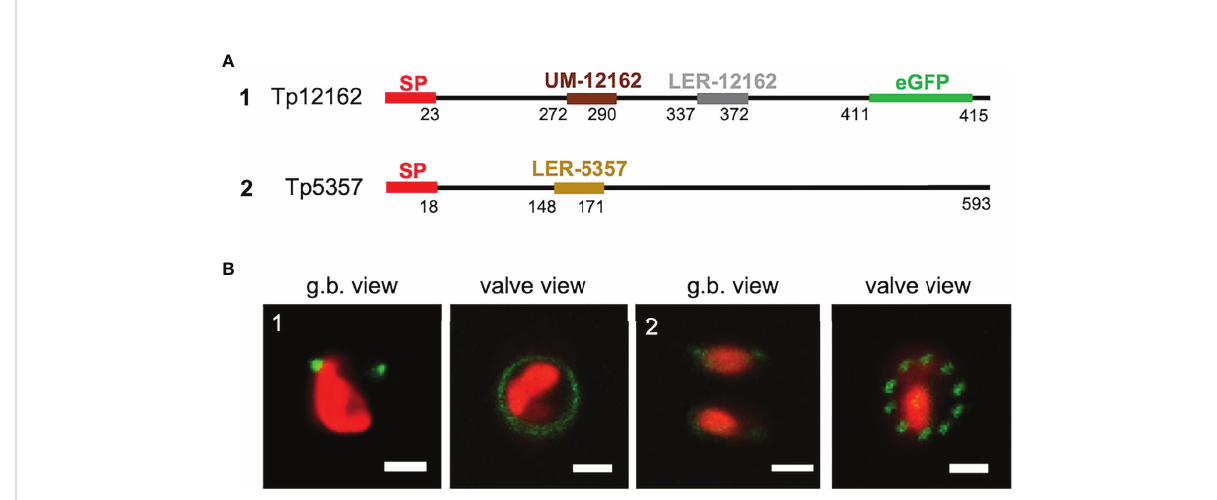
FIGURE 5 Localization experiments with the Tp12162 and Tp5357 eGFP-fusion proteins. (A) shows a graphical depiction of the constructs used for the experiments. The color code is: red for the signal peptide (SP), brown for the UM-12162, grey for LER-12162, ochre for LER-5357, black for the protein backbone; the eGFP is shown only for construct Tp12162-eGFP, as its position is internal. (B) shows images (merged eGFP and PAF channels) of live cells selected from in vivo localization experiments performed using the constructs shown in the upper panel. Scale bars: 2